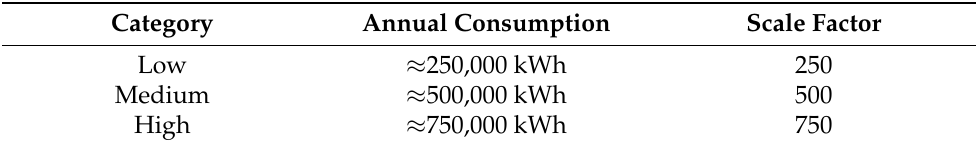
Table 2. Types of artificial load profiles for BML agents.